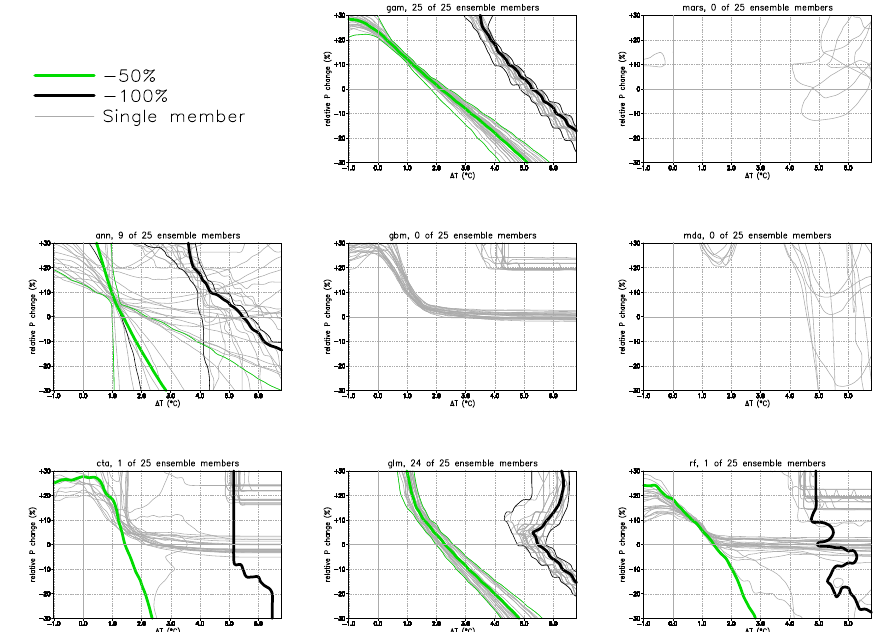
Fig. A3. As in Fig. A1, but for models calibrated for the 1971–2000 baseline period.